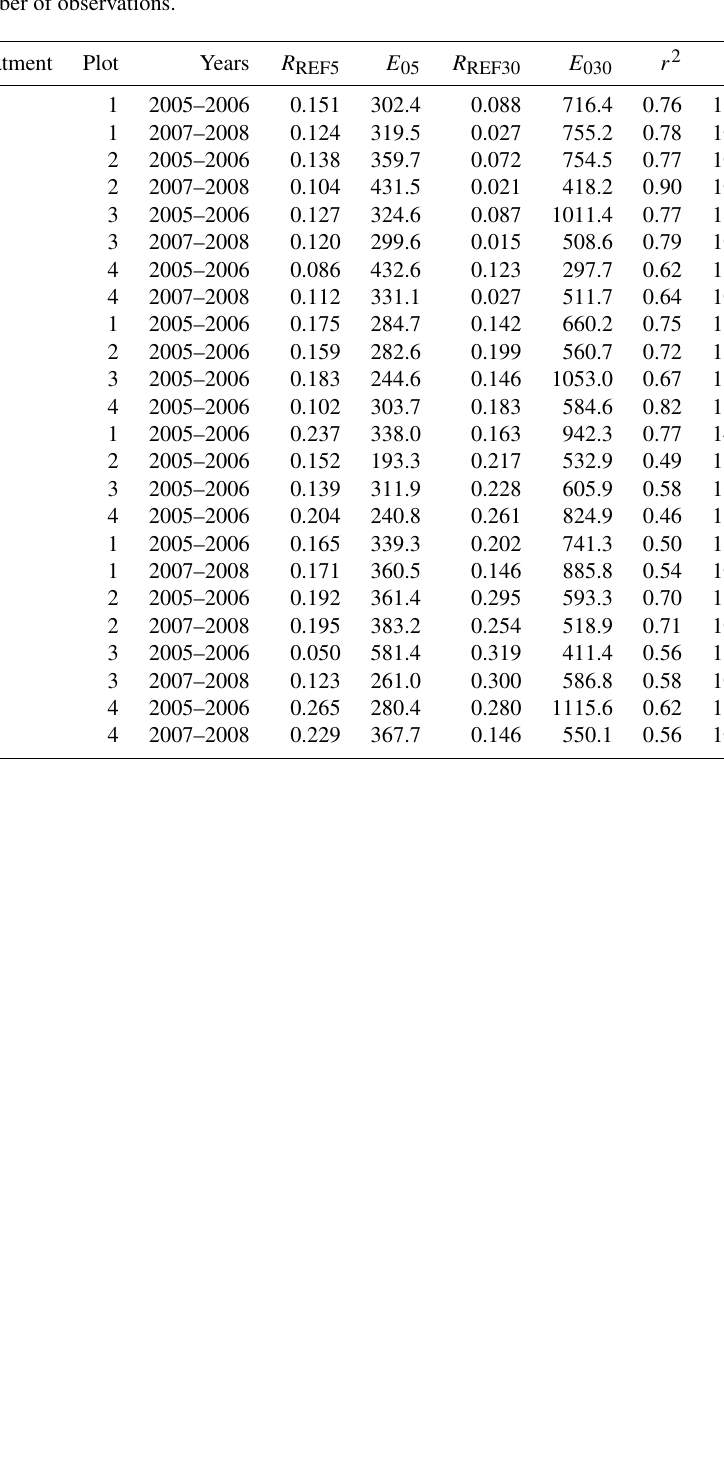
Table C1. Parameter values of forest floor CO 2 efflux models (Eq. 1) for different collar treatments (A = peat, B = peat + litter, C = peat + litter + roots and D = peat + litter + roots + ground vegetation) and years. R REF5 and R REF30 are respirations at 10 ◦ C for the 5 and 30cm depths (gCO 2 m − 2 h − 1 ) , E 05 and E 030 are is temperature sensitivities of respiration for the same layers, r 2 is coefficient of determination of the model, and n is the number of